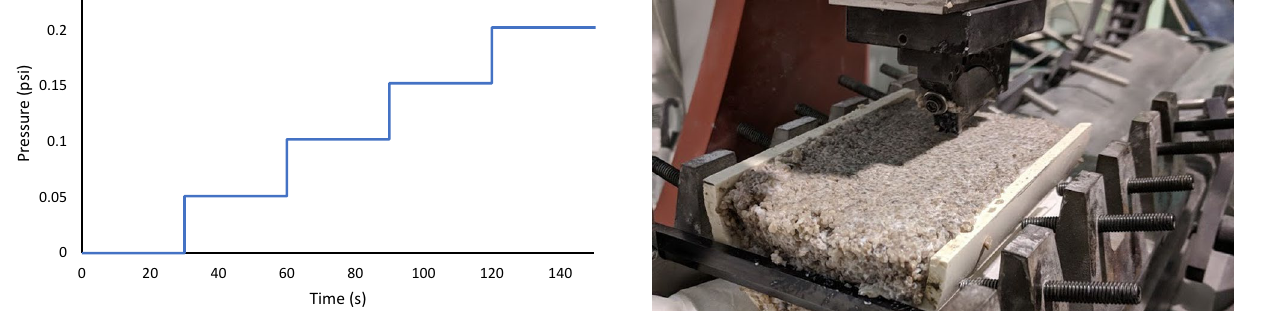
Fig. 4 Calibration step data (averages shown)